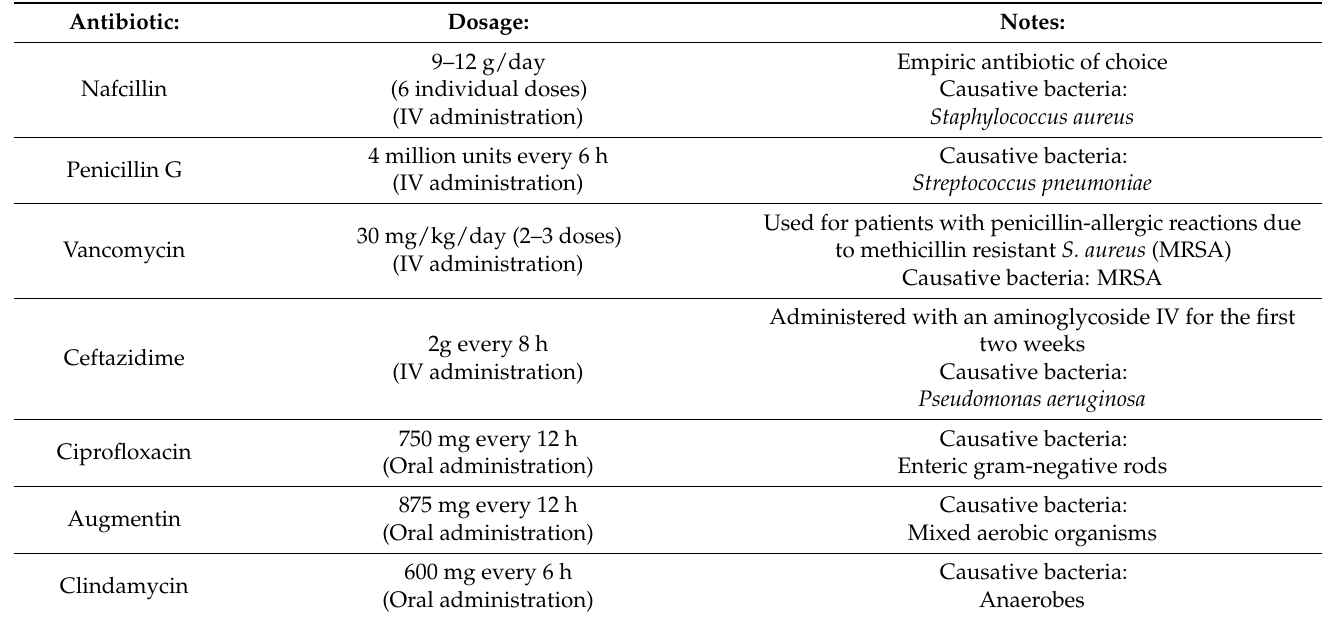
Table 3. Antibiotic regimens for the treatment of osteomyelitis.